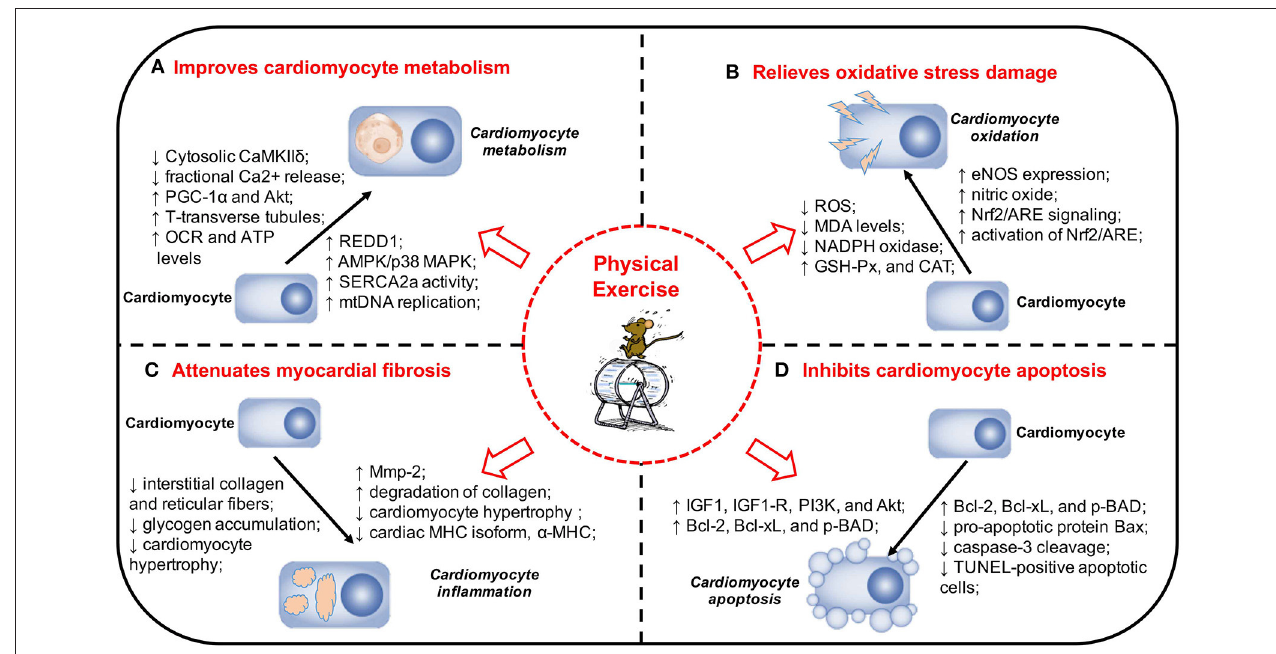
FIGURE 1 | Physical exercise and its protective effects and potential mechanisms in DCM. (A) Physical exercise Improves cardiomyocyte metabolism in DCM. (B) Physical exercise relieves oxidative stress damage in DCM. (C) Physical exercise attenuates myocardial fibrosis in DCM. (D) Physical exercise inhibits cardiomyocyte apoptosis in DCM. The pathogenesis of DCM is a multifactorial process and a range of mechanisms play a significant role in the onset and development of DCM. Physical exercise can exert a variety of protective effects on DCM, including improving cardiomyocyte metabolism, relieving oxidative stress damage, attenuating myocardial fibrosis, and inhibiting cardiomyocyte apoptosis. DCM, diabetic cardiomyopathy; MAPK, mitogen-activated protein kinase; REDD1, regulated in development and DNA damage response 1; SERCA2a, sarcoplasmic reticulum Ca2 + -ATPase; mtDNA, mitochondrial DNA; PGC-1 α , Peroxisome proliferator-activated receptor gamma coactivator 1-alpha; Akt, protein kinase B; VO2max, maximal oxygen consumption; EF, ejection fraction; FS, fractional shortening; OCR, oxygen consumption rate; ATP, adenosine triphosphate; eNOS, endothelial nitric oxide synthase; NADPH, nicotinamide adenine dinucleotide phosphate; Nrf2, nuclear factor erythroid 2-related factor 2; ARE, antioxidant responsive element; MDA, malondialdehyde; SOD, superoxide dismutase; GSH-Px, glutathione peroxidase; CAT, catalase; MHC, myosin heavy chain; Mmp-2, matrix metalloproteinase-2; IGF1, insulin-like growth factor 1; IGF1-R, IGF1-receptor;